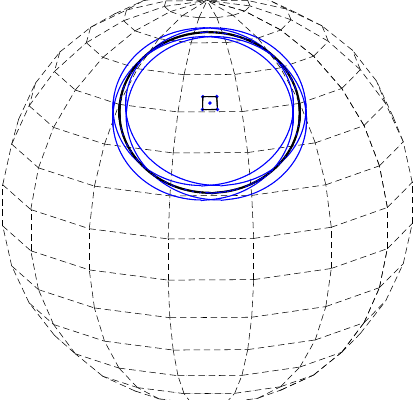
Figure 10. A cell centered at ( θ max , ϕ max ) . The black circle is the common secondary circle defined by the center of this cell. The four blue circles are the circles defined by the corners of the cell. Given one of the (corner) circles defined by a corner point (the blue circle in Figure 11), the largest distance from the common secondary circle is achieved by two critical points (red points in Figure 11) on the corner circle. One critical point is closer than the common secondary circle to the cell center, whereas the other critical point is more distant than the common secondary circle from the cell center.